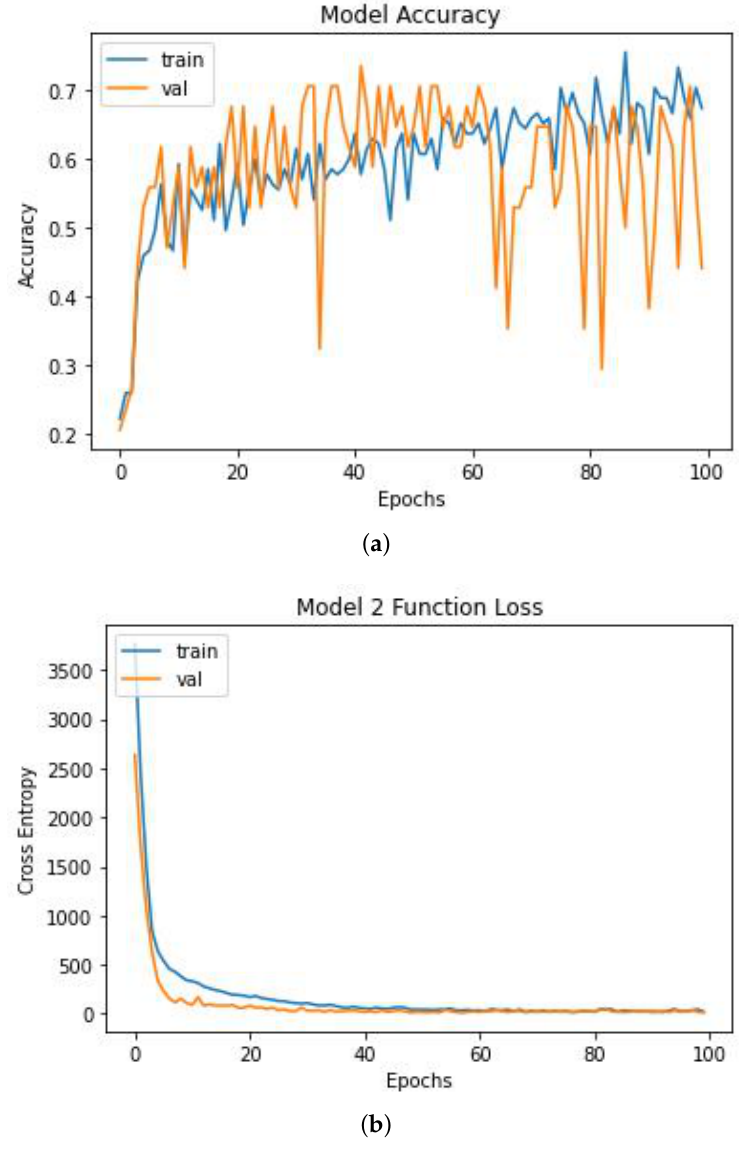
Figure 6. Accuracy ( a ) and function loss ( b ) for Model 2 with MLP